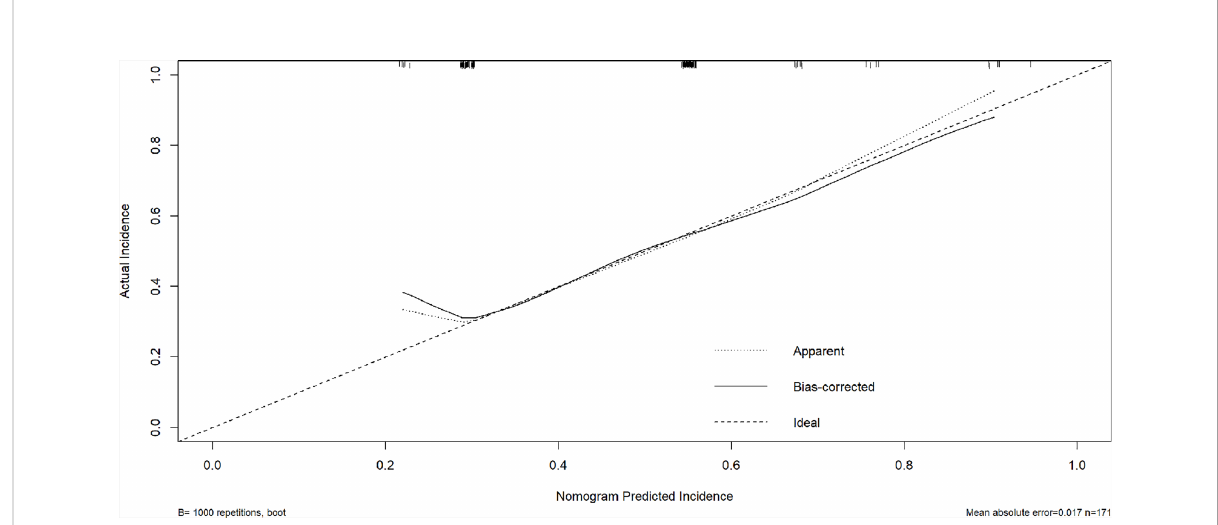
FIGURE 5 ROC of the Novel Nomogram of CR-POPF in OCP Patients. A ROC curve was constructed to evaluate the model. The area under the ROC curve was 0.678. ROC, receiver operating